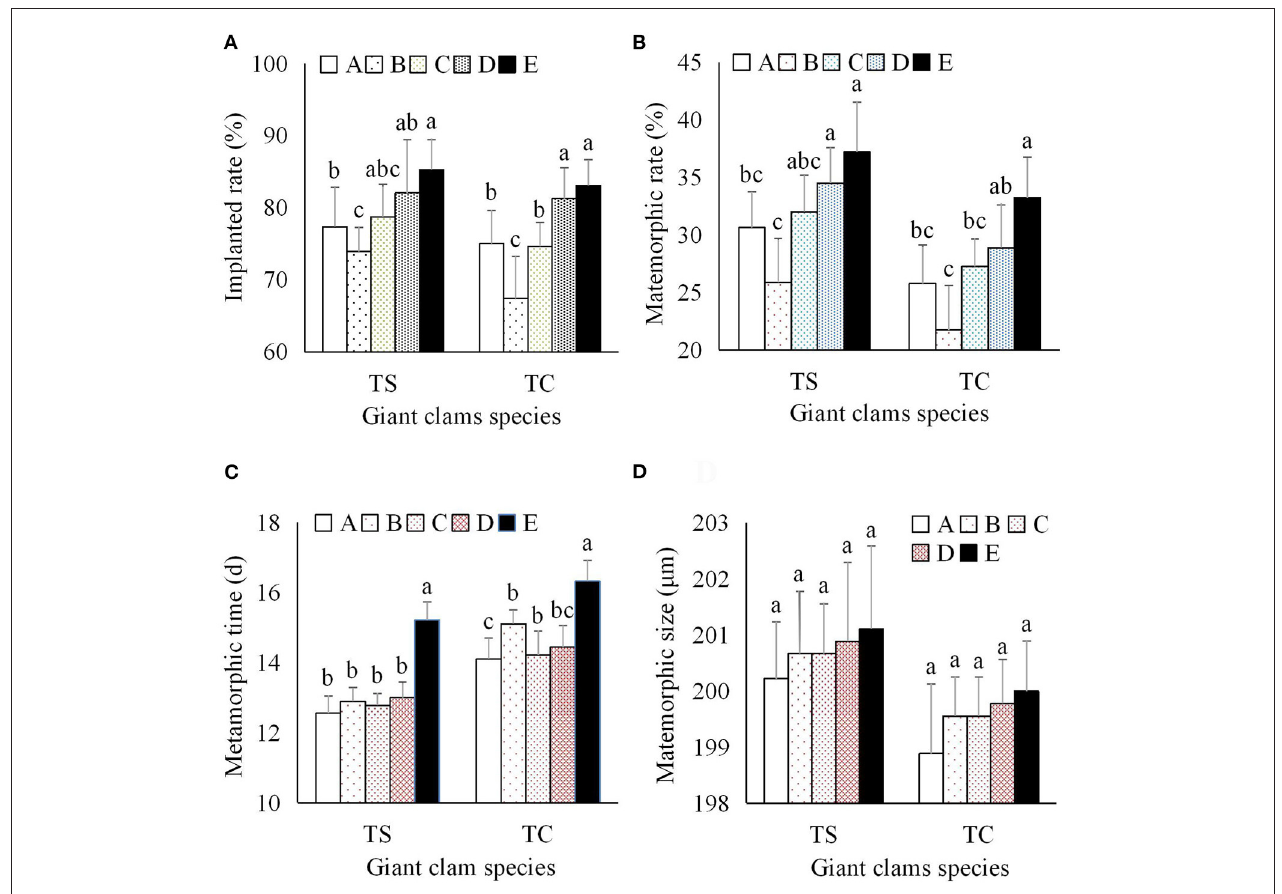
FIGURE 4 | Effects of zooxanthellae clades A–E on metamorphosis indices of T. squamosa and T. crocea progeny. (A) Implantation rate of zooxanthellae; (B) Metamorphic rate; (C) Time to metamorphosis; (D) Size at metamorphosis.